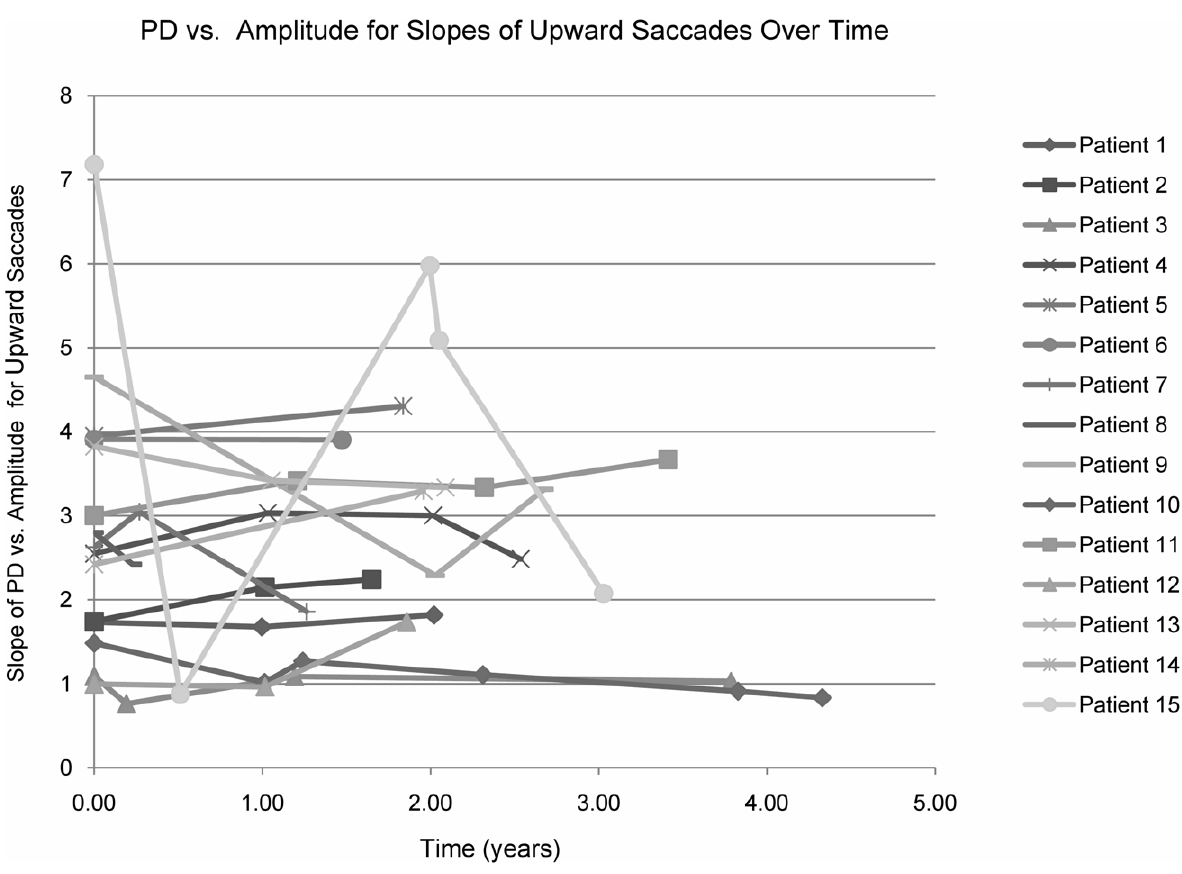
Figure 4. Slope of peak duration vs amplitude for upward saccades over time. Each point represents the results for a specific visit time.